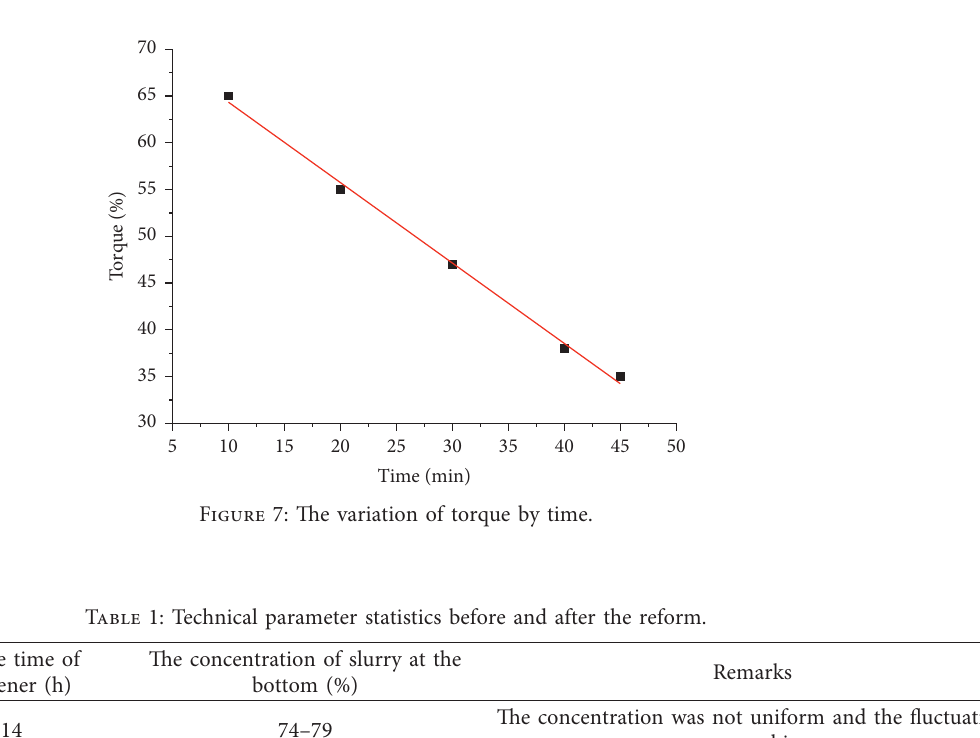
Figure 6: Arrangement plan of spray nozzles.